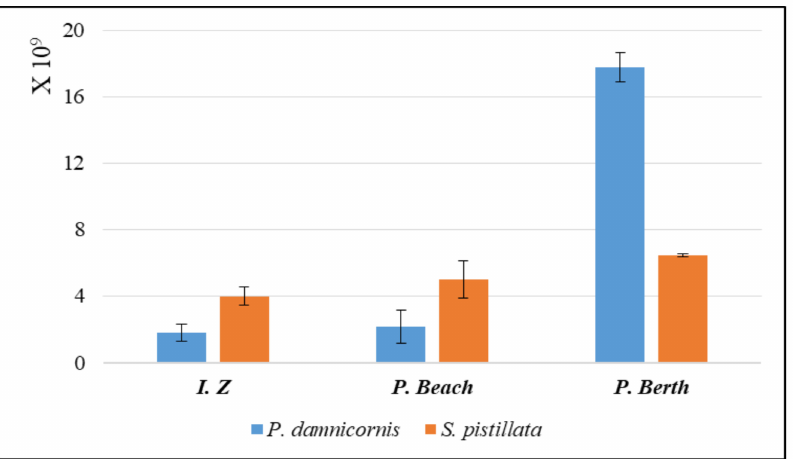
Figure 2. Viable bacterial count associated with the mucus of P. damicornis and S. pistillata expressed in colony-forming units per mL (CFU/mL). (I.Z: Industrial Zone, P. Beach: Public Beach, P. Berth: Phosphate